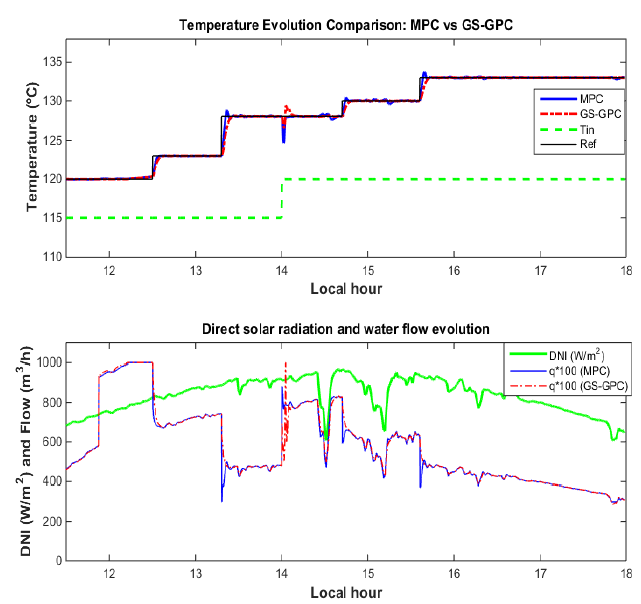
Figure 12. Simulation 1: Tracking